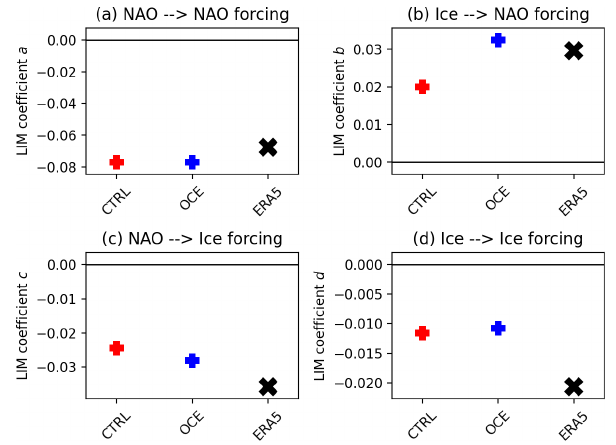
Figure 9. Estimated coefficients of the LIM model, as described by Eqs. (1) and (2). In (a) , the coefficient a , describing the forcing of the NAO on itself 1d later, (b) the coefficient b , describing the forc- ing of sea ice on the NAO 1d later, (c) the coefficient c , describing the forcing of the NAO on sea ice 1d later, and (d) the coefficient d , describing the forcing of sea ice on itself 1d later. CTRL and OCE data are marked in red and blue, respectively. ERA5 is shown with a black cross. Daily data covering November–February, 1980–2015, are